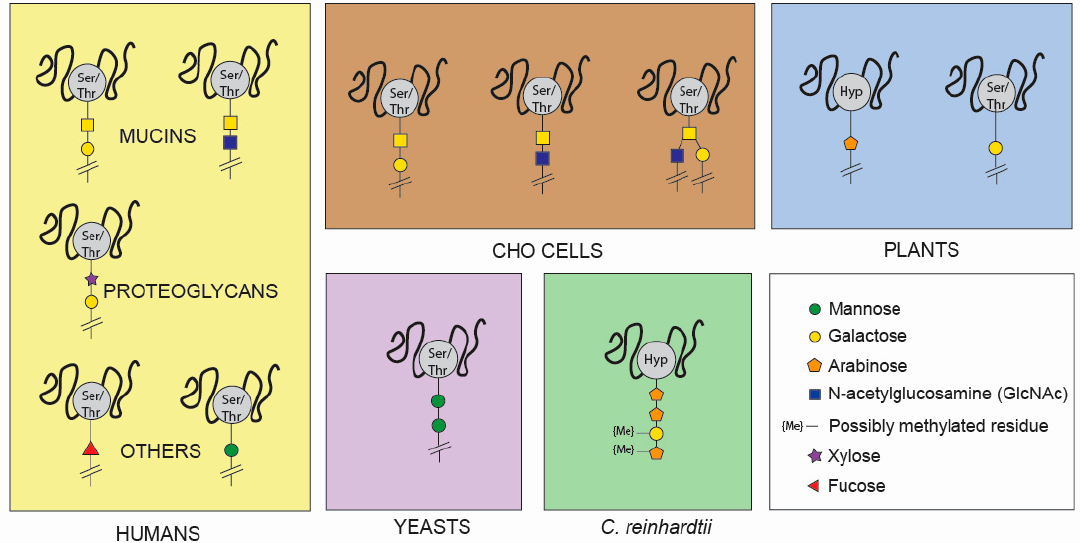
Figure 2. A comparison of the different O -glycosylation patterns among humans, CHO cells, yeasts, plants, and microalgae. Experimental evidence for O -glycosylation in microalgae is limited to C. reinhardtii [124]. Native C. reinhardtii proteins possess a (Hyp- O -Ara-Ara) core and methylated residues, characteristics that differ significantly from human O -glycosylation patterns. Ser/Thr = serine or threonine. Hyp = hydroxyproline. Green circle = Mannose. Yellow circle = Galactose. Orange pentagon = Arabinose. Blue square = GlcNAc. Me = Methylated residue. Purple star = Xylose. Red triangle = Fucose.